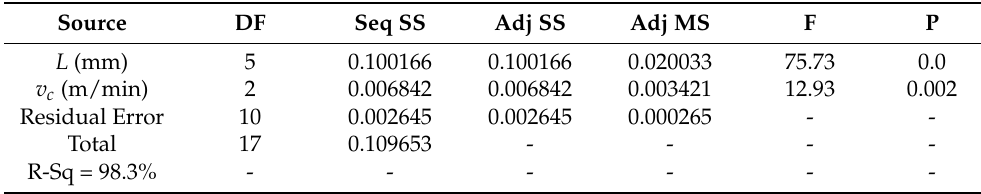
Table 9. ANOVA statistical analysis for VB (mm).